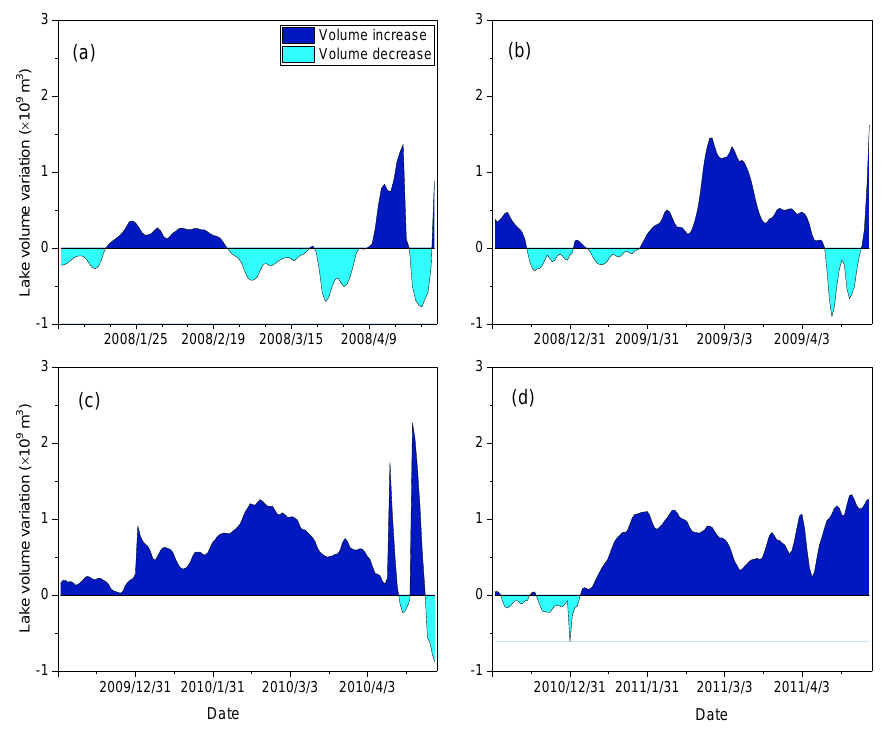
Figure 8. Volumetric differences during dry seasons with and without the TGR (2008–2011). ( a – d ) denote the water compensation periods of each year from 2008 to 2011.